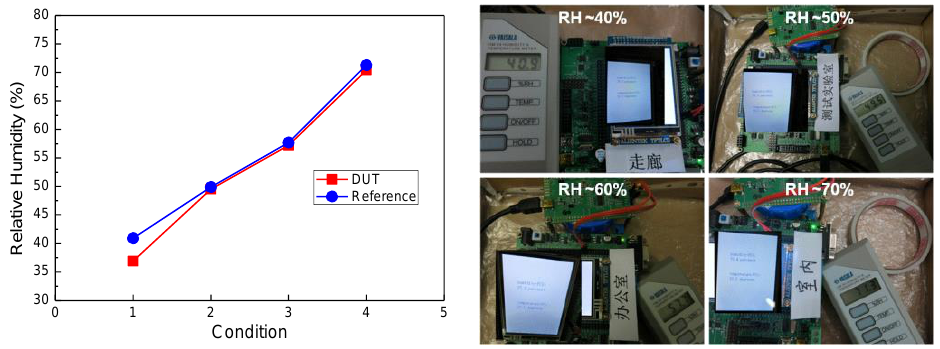
Figure 14. Measured humidity data of the prototype sensor ( Left ) and measurement photo of the prototype sensor and standard sensor ( Right ).